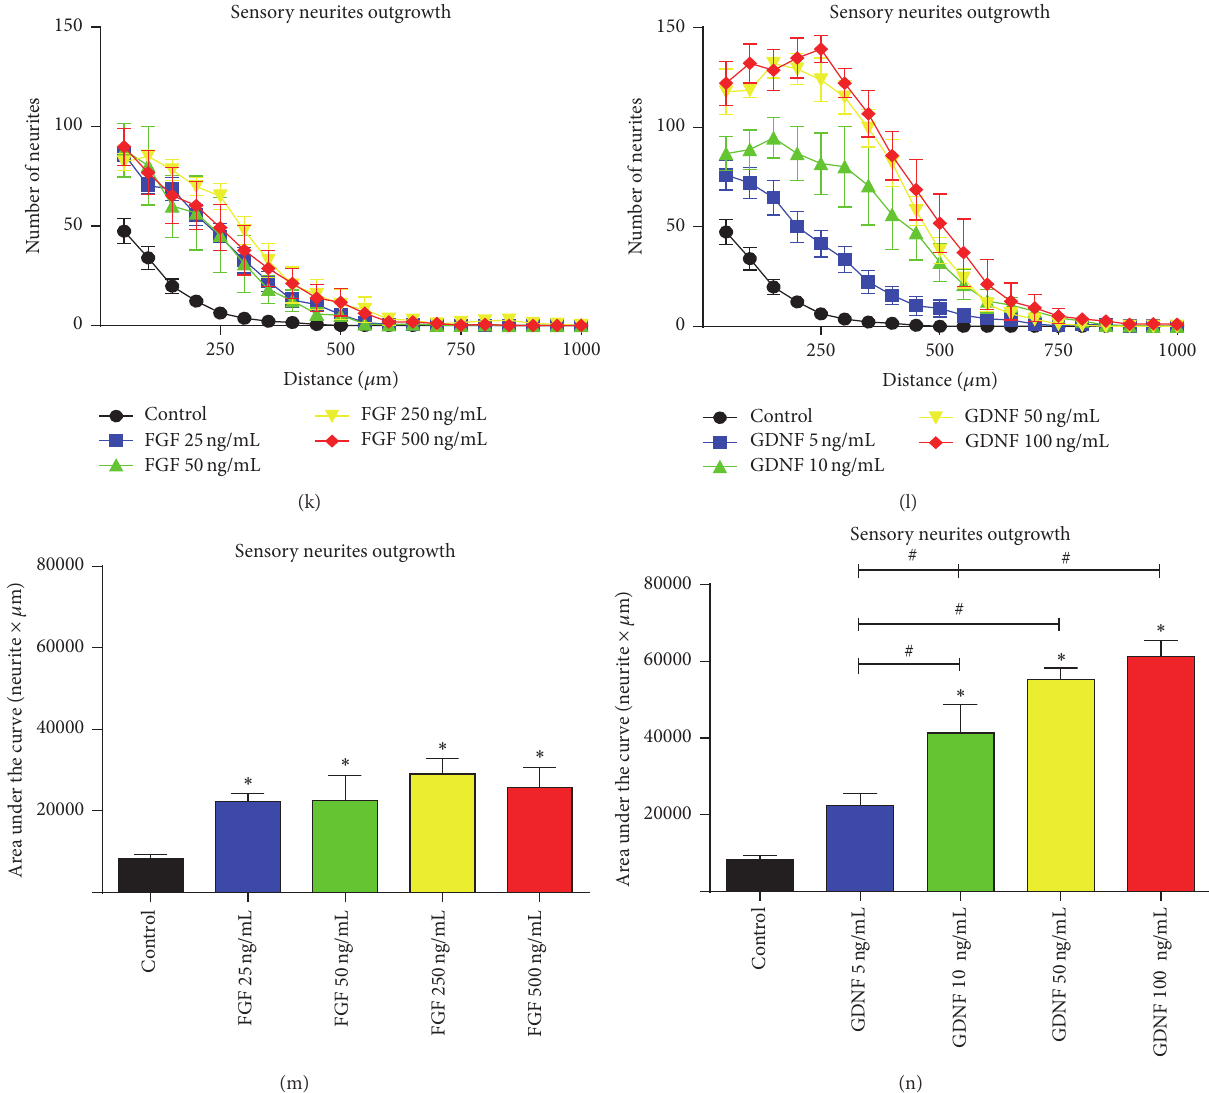
Figure 1: Representative images of RT97 stained neurites from spinal cord slices (a–c) and DRG neurons (d–f) cultured within a 3D collagen matrix alone (a, d) and with addition of 500 ng/mL of FGF-2 (b, e) or 100ng/mL of GDNF (c, f). Quantification of the number of neurites grown at increasing distance from the spinal cord slices (g, h) and from DRG body (k, l) after the addition of FGF-2 and GDNF. Plots of the quantified AUC from (g), (h), (k), and (l) graphs for motor (i, j) or sensory (m, n) neurite outgrowth. Data expressed as mean ± SEM. ∗ 𝑝 < 0.05 versus control; # 𝑝 < 0.05 . Scale bar: 100 𝜇 m (a) and 200 𝜇 m